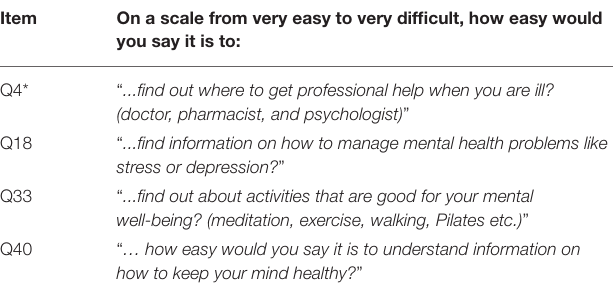
TABLE 1 | MHL-associated items from the